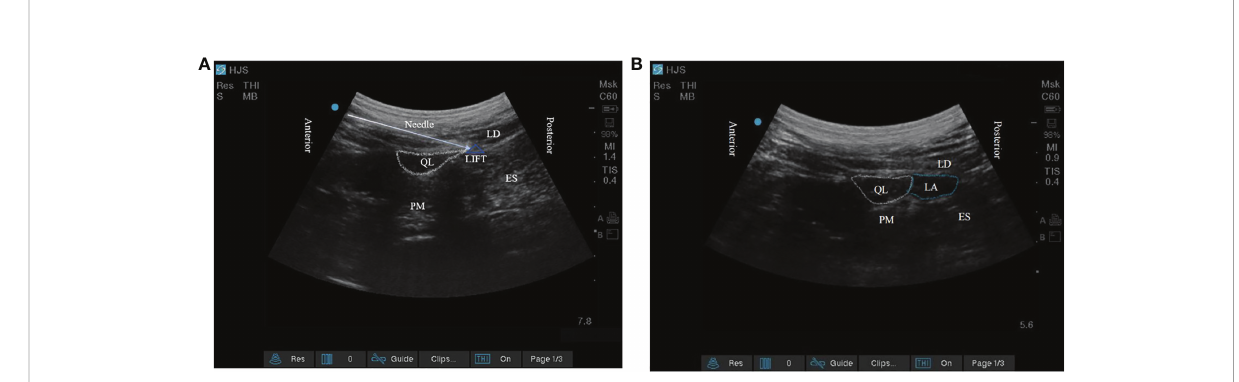
FIGURE 1 (A) The target of posterior quadratus lumborum block; (B) The local anesthetic diffuses within the lumbar interfascial triangle. QL, quadratus lumborum; PM, psoas major; LD, latissimus dorsi; ES, erector spinae; LIFT, lumbar interfascial